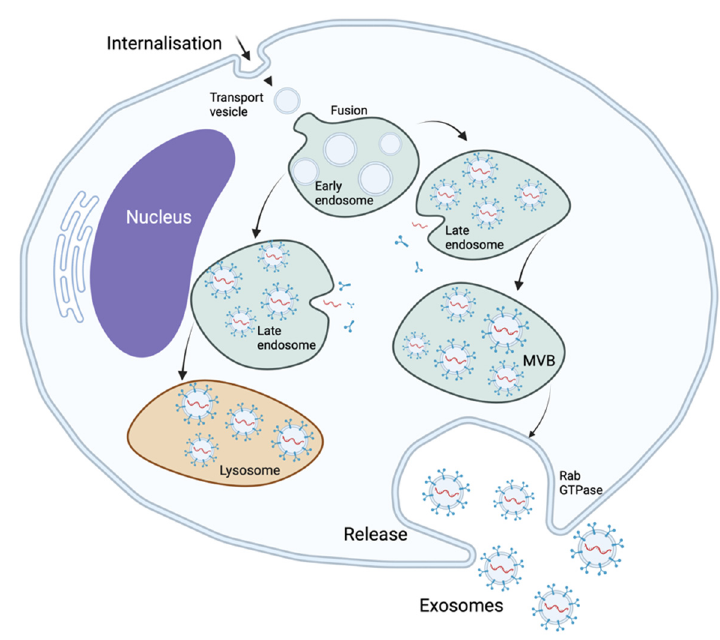
Figure 1. Exosomal biogenesis .